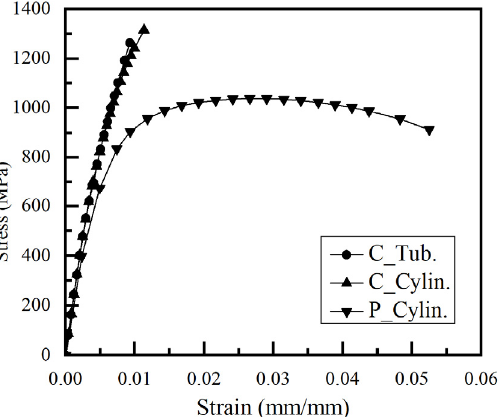
Figure 5. Stress–strain curves obtained from tensile tests of three di ff erent specimens. Table 1. Tensile properties of the materials.